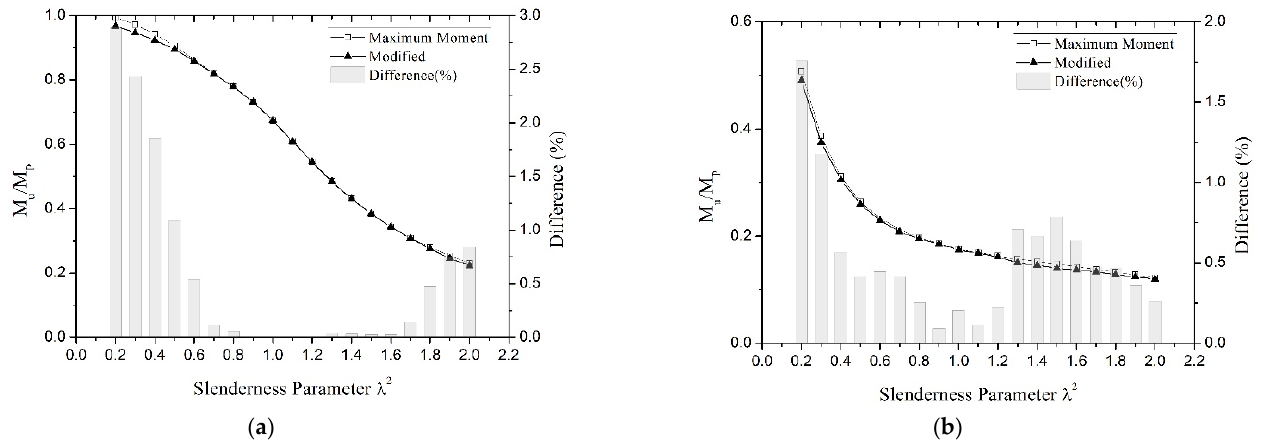
Figure 5. Ultimate Moments Obtained by Two Different Methods: ( a ) straight members; ( b ) curved members.